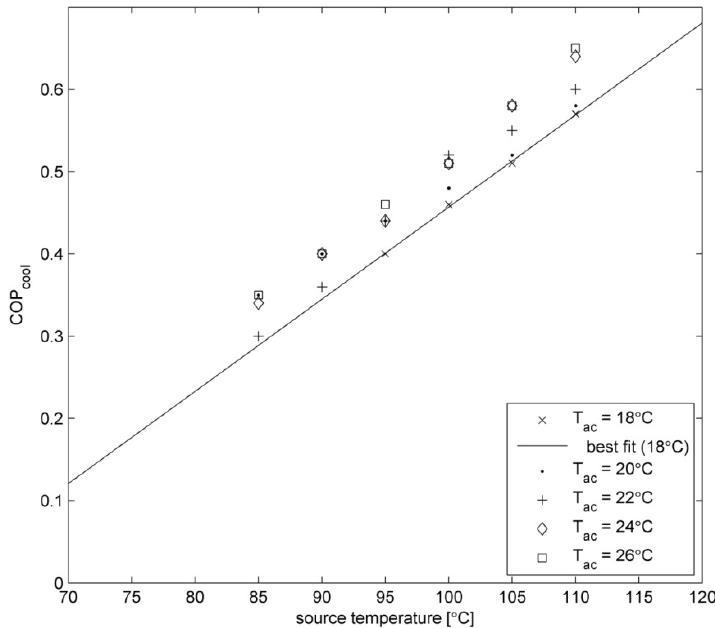
Figure 8. COP against heat source for 25 °C heat sink temperature.